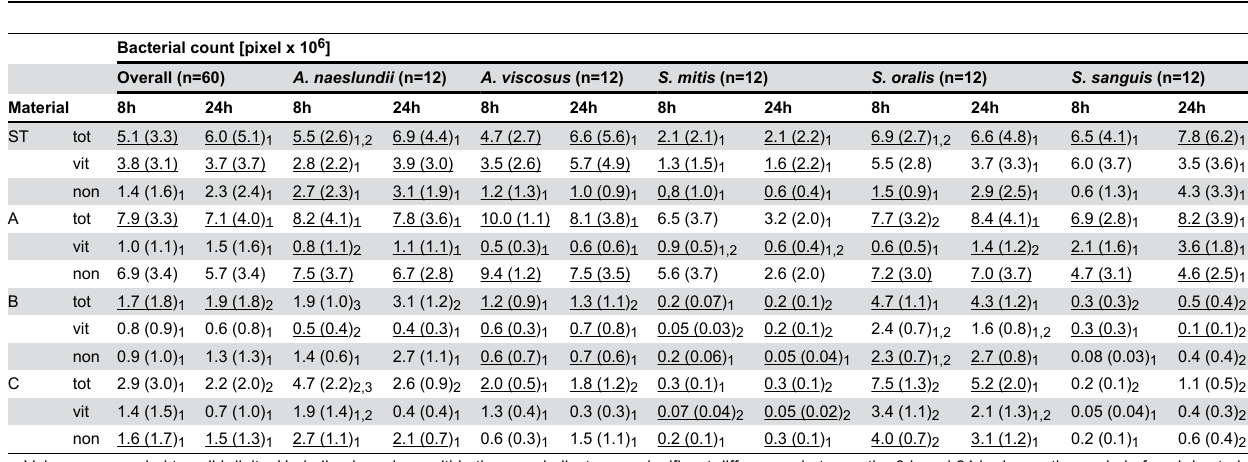
Table 5. Means and (standard deviations) of total, vital bacterial and non-vital bacterial pixel-count after 8 h and 24 h observation